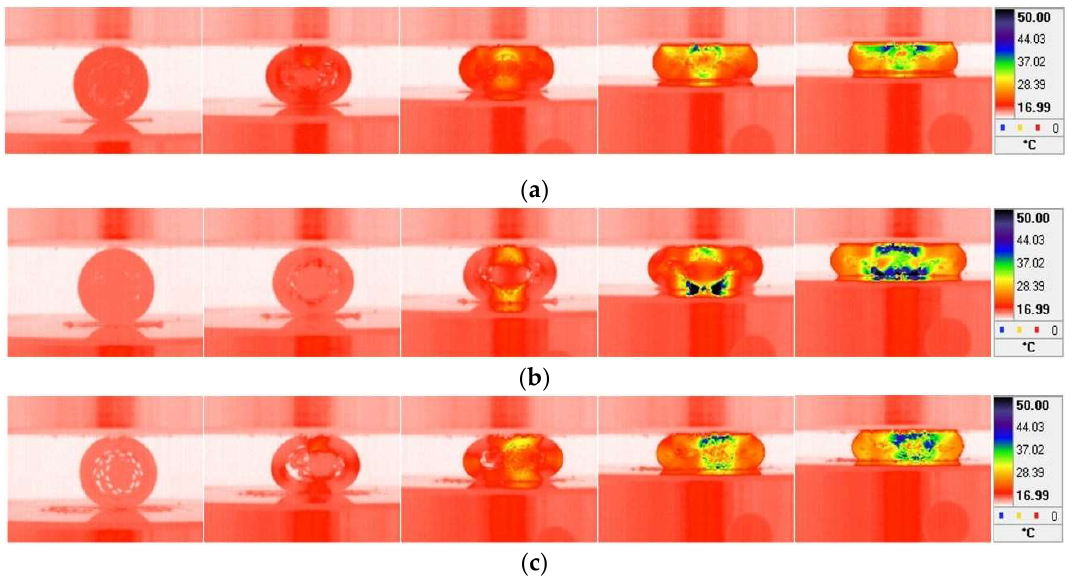
Figure 10. IR thermography images of the dynamic loading sequence (strain increment: ~0.15): ( a ) Specimen No. 1; ( b ) Specimen No. 2; ( c ) Specimen No. 4.